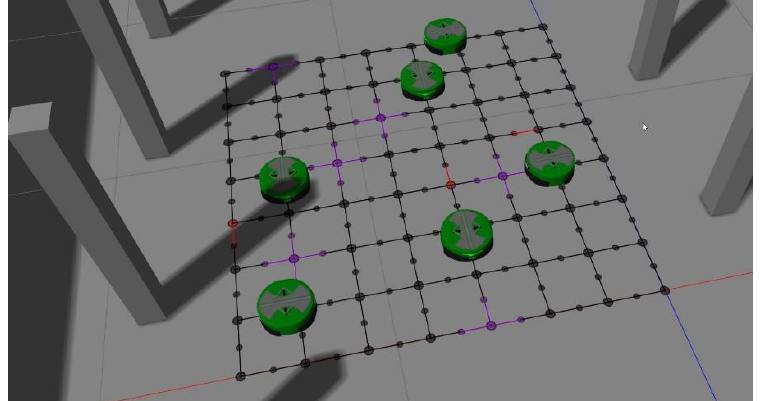
Figure 11. The graph structure network (GSN): violet crossroads denote the use of an infinity intention pheromone (IIP); red virtual segments refer to traveling intention ants (IAs). We evaluated two approaches: (a) with reservations (WRA) and (b) without reservations (NRA).